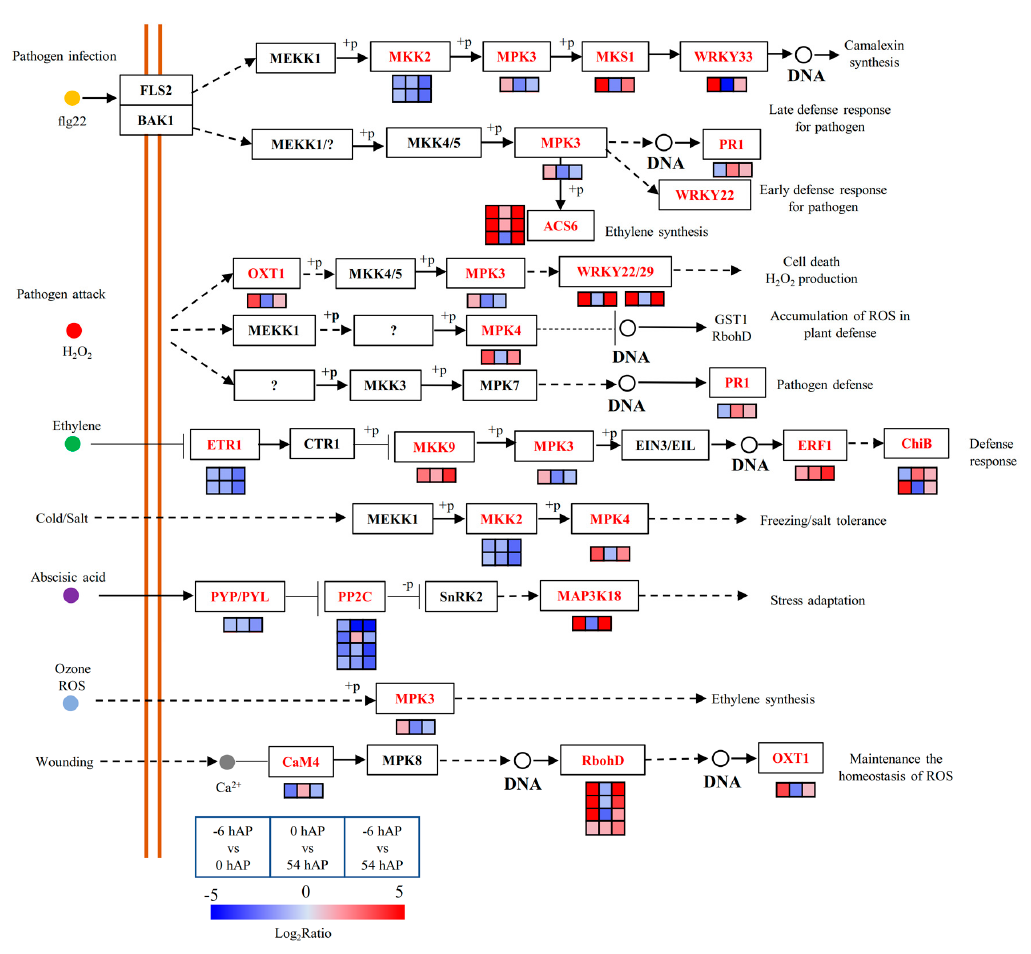
Figure 5. The significantly expressed common genes assigned into the MAPK signaling pathway during the early phases of AR formation in mulberry stem hardwood cuttings. The enriched common genes are in red, and the changes of transcriptional expression levels in the three comparison groups are illustrated with colored boxes. The boxes from the left to right indicate − 6 hAP vs. 0 hAP, 0 hAP vs. 54 hAP, and − 6 hAP vs. 54 hAP, respectively. Each row of boxes represents a mulberry homolog gene. The color code from blue to red represents the changes of transcriptional expression level between –5 and 5. The solid or dashed arrows indicate direct or indirect positive effects, and the T type lines indicate inhibitory effects. This figure is redrawn based on the KEGG pathways.